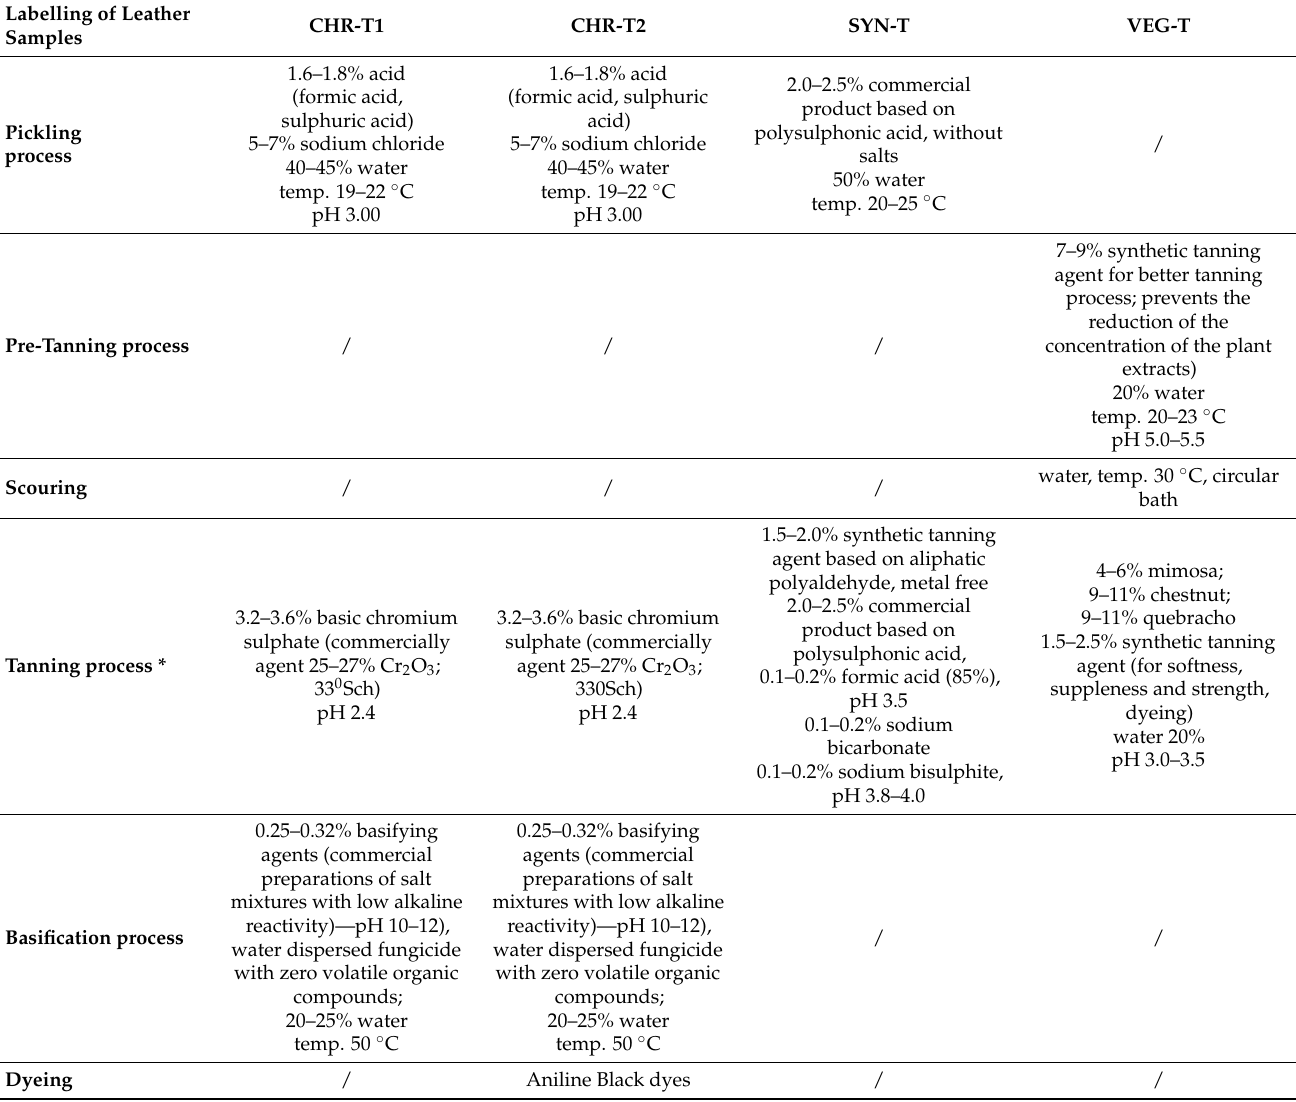
Table 1. Basic parameters of the technological processes in the tanning of leather with different tanning